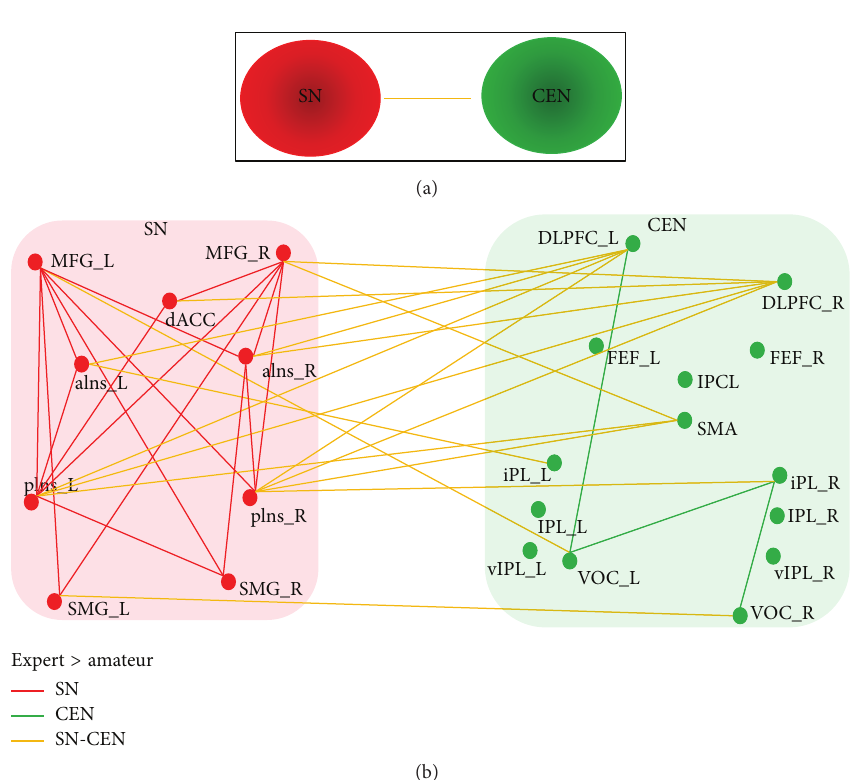
Figure 3: The significantly enhanced FC in the experts. (a) indicates enhanced FC between SN and CEN based on the correlational analysis between the average nodal signal of SN and CEN (yellow lines indicate 𝑝 < 0.001 ). (b) indicates enhanced FC at the nodal level (FDR, 𝑝 < 0.05 ). Red dots are the nodes of SN; red lines are the edges of SN; green dots are the nodes of CEN; green lines are the edges of CEN; yellow lines are edges of